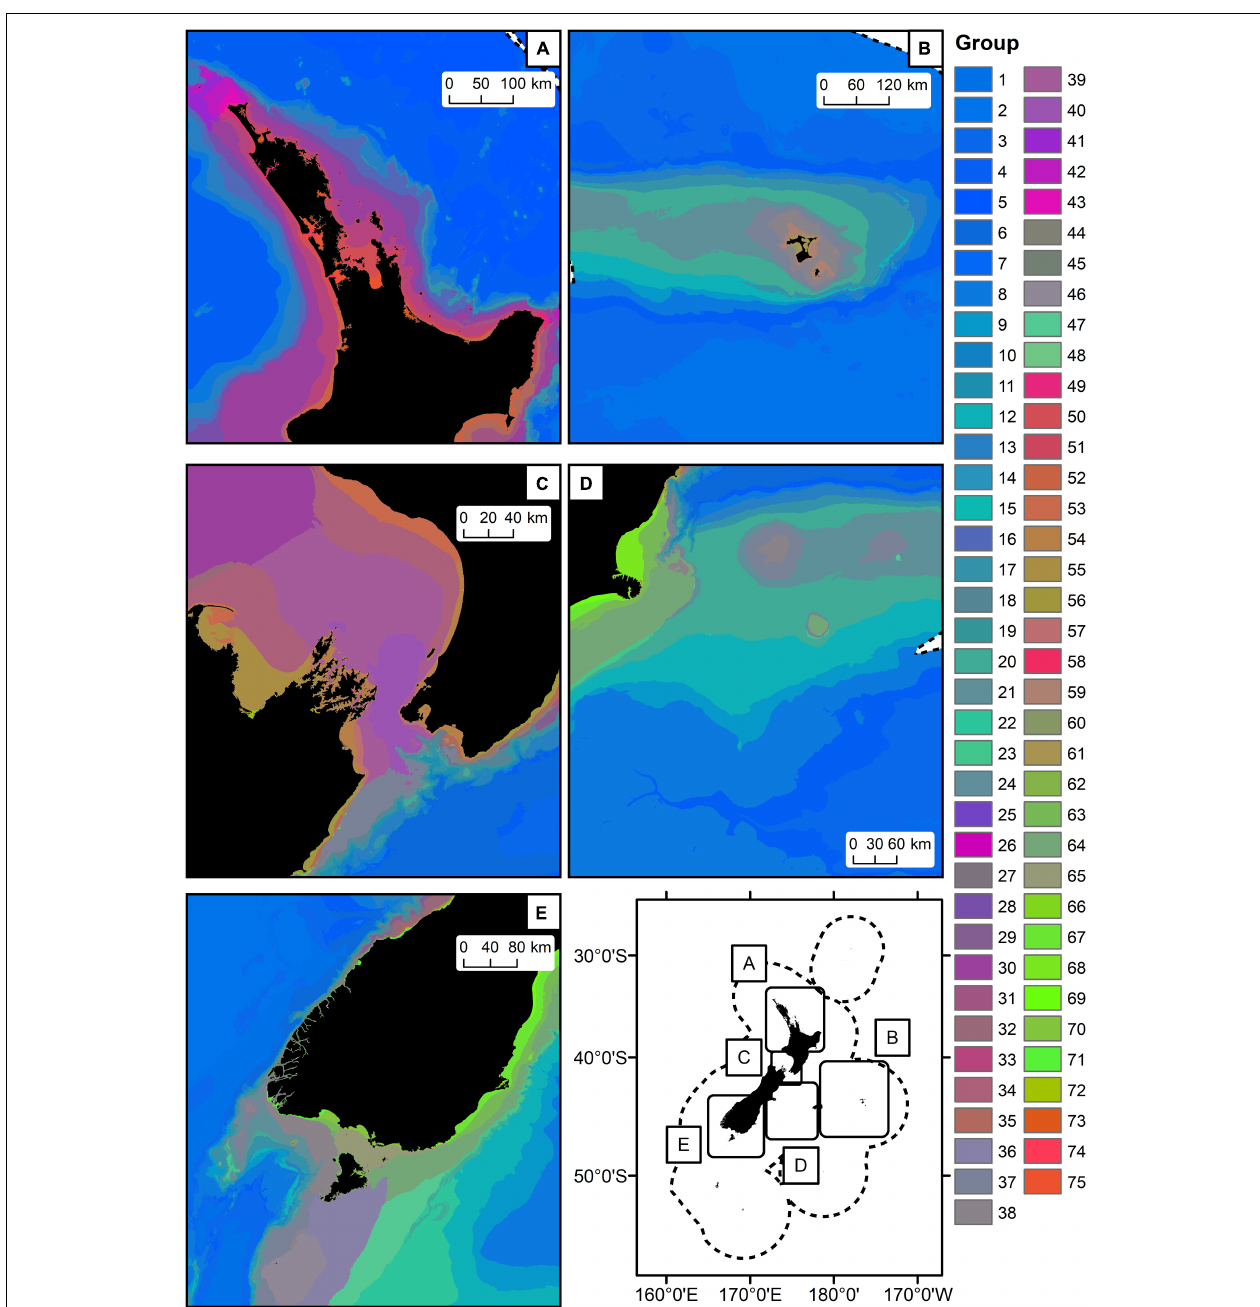
FIGURE 6 | Closeup views of parts of the geographic distribution of the Seafloor Community Classification (75 groups, panels A–E ) derived from combined bootstrapped Gradient Forest model. Colours are based on the first three axes of the PCA analysis applied to the group means for each of the transformed predictor variables, so that similarities/differences in colour correspond broadly to similarities/differences in predicted compositional